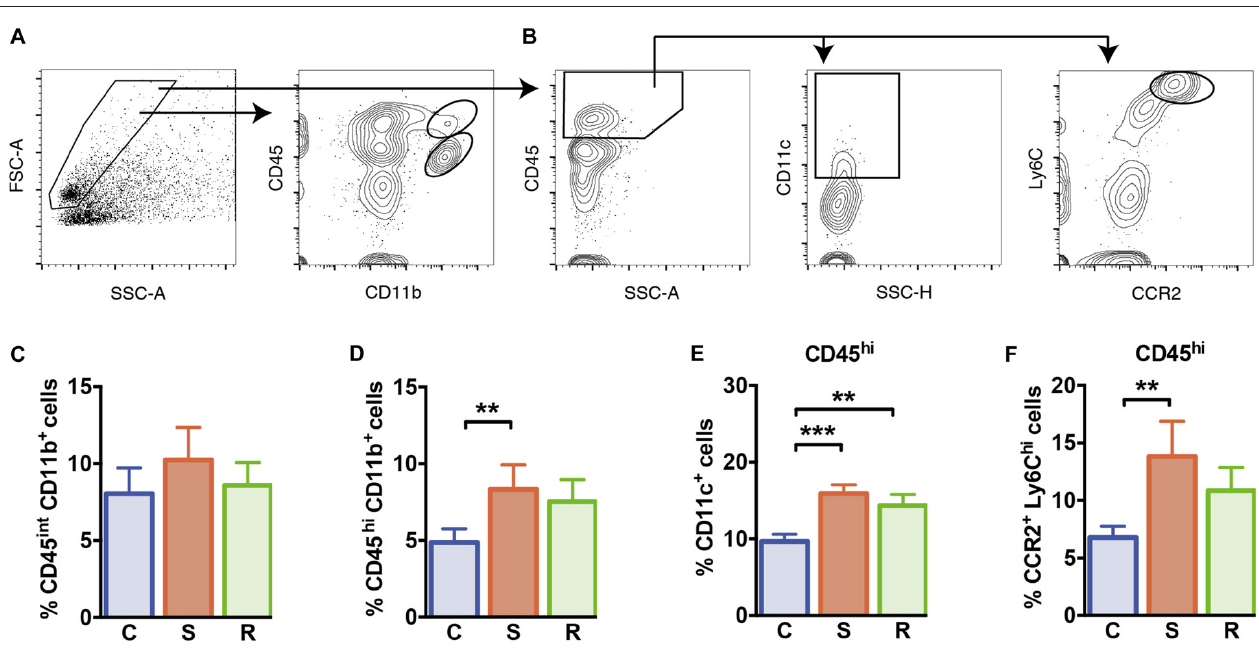
FIGURE 5 | Microglia and peripheral myeloid cells in the brain. (A) Gating of CD45 int CD11b + microglia and CD45 hi CD11b + brain invading myeloid cells. (B) Gating of CD11c + DCs and CCR2 + Ly6C hi inflammatory monocytes of CD45hi brain invading peripheral cells. (C) Similar percentages of CD45 int CD11b + microglia. (D) Significantly increased percentages of CD45 hi CD11b + brain invading myeloid cells in susceptible mice. (E) Increased percentages of CD11c + DCs among CD45 hi brain invading immune cells in socially defeated mice. (F) Significantly increased percentages of CCR2 + Ly6C hi inflammatory monocytes among CD45 hi brain invading immune cells in susceptible animals. Bar graphs represent mean + SEM. C, control; S, susceptible; R, resilient. CD45 int / hi CD11b + : n C = 16, n S = 13, n R = 15. CD45 hi CD11c + , CD45 hi CCR2 + Ly6C hi : n C = 10, n S = 9, n R = 9. ∗∗ p < 0.01, ∗∗∗ p <